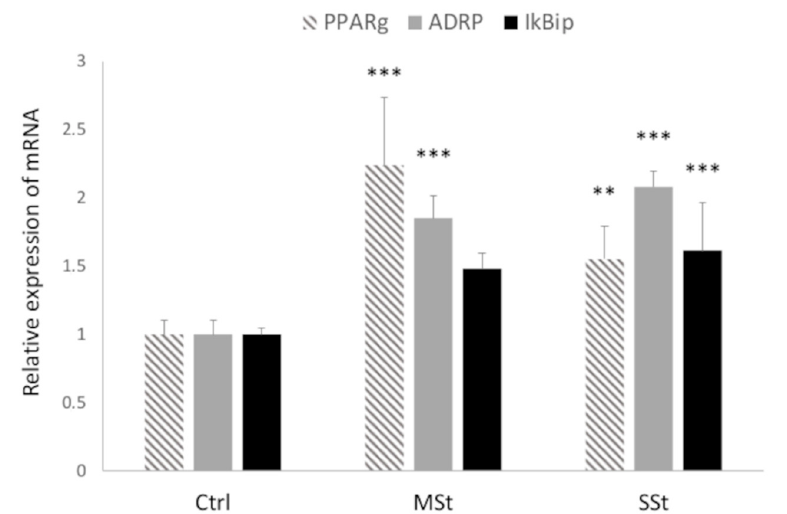
Figure 3. Modulation of cell function in moderate and severe steatosis models. The mRNA expression of PPAR γ , ADRP and of IkBip were evaluated by qPCR using GAPDH as the internal control. Data are expressed as fold induction with respect to controls. Bars represent SD. ANOVA followed by Tukey’s test was used to assess the statistical significance between groups. Symbols: Ctrl vs. all treatments ** p ≤ 0.01, *** p ≤ 0.001.